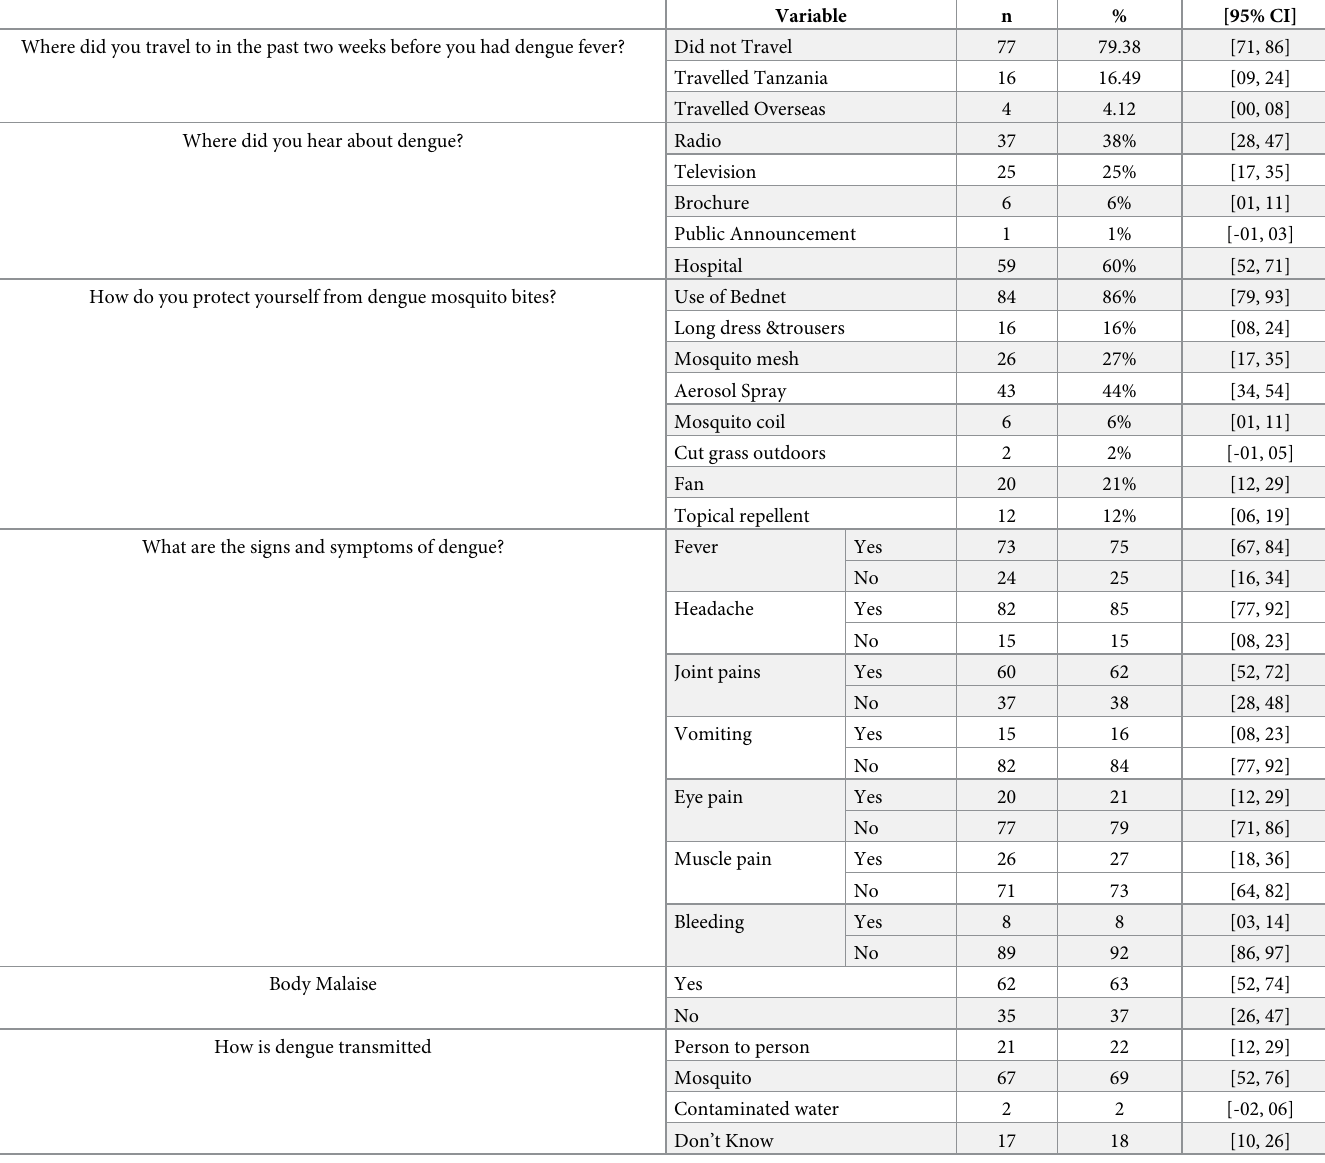
Variable n % [95% CI]